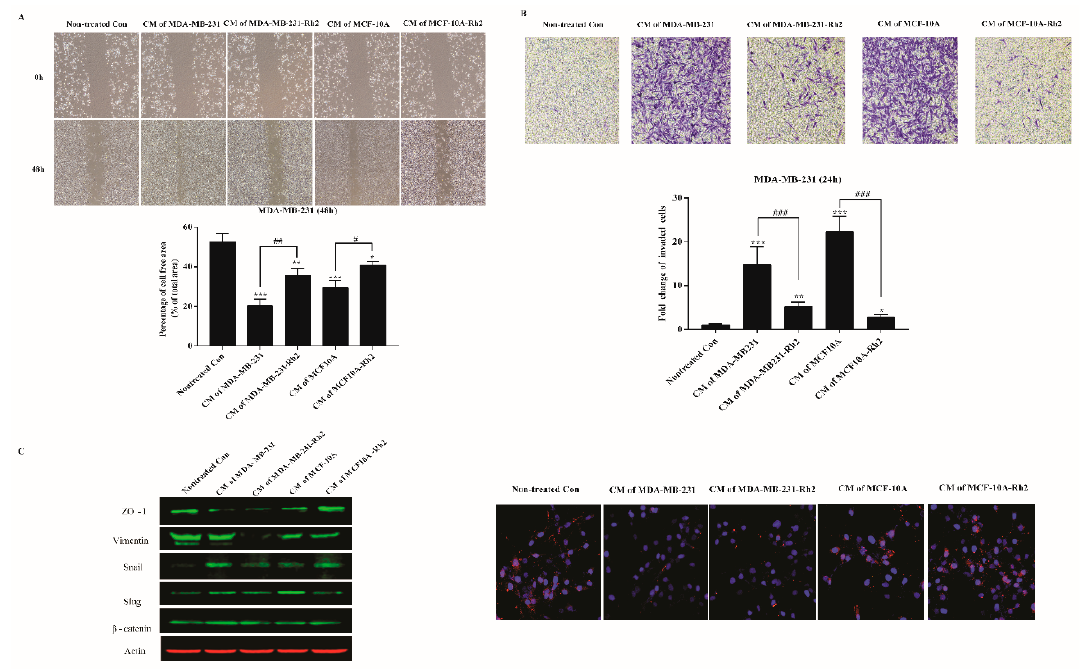
Figure 3. Rh2 inhibited SASPs-induced migration and invasion of breast cell lines. ( A ) MDA-MB-231 cells were cultured with conditioned medium from senescent MDA-MB-231 and MCF-10A cells treated with or without Rh2 for 48 h. The cell-free areas were imaged with microscope at 0 h and 48 h, respectively. The changes in cell-free area were calculated using CellProfiler Software (2.2.0). At least three wound scratches were analyzed per experiment. ( B ) Invasion of MDA-MB-231 cells (5 × 10 4 /well) as determined by 24-well plate transwell system. Cells on the lower side of membranes were stained and quantified. ( C ) Western blot analysis of representative epithelial–mesenchymal transition (EMT) markers of MDA-MB-231 cells after CM treatment. Immunostaining for the tight junction protein ZO-1(Red) and the nuclear regions were counterstained with DAPI (blue). * indicates p < 0.05 versus Nontreated con, ** indicates p < 0.01 versus Non-treated con; *** indicates p < 0.001 versus nontreated con. ## indicates p < 0.01 versus CM alone group. ### indicates p < 0.001 versus CM alone group.